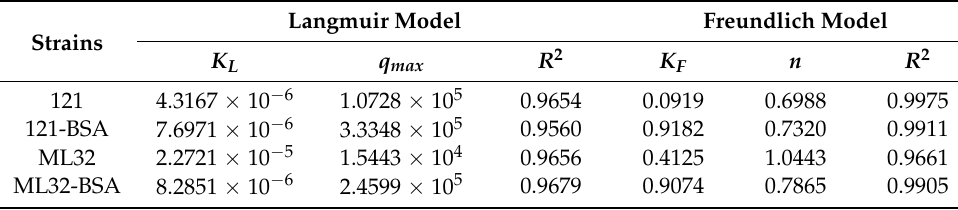
Table 4. The Langmuir and Freundlich isothermal model fitting results.